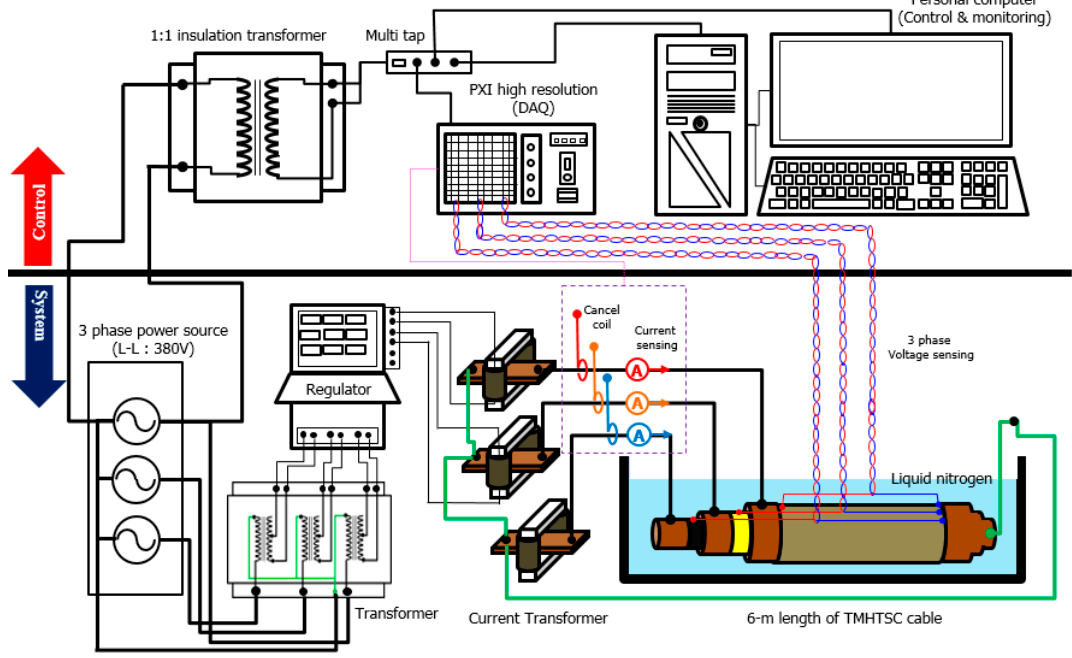
Figure 13. Configuration concept of AC loss measurement for the 6-m-long tri-axial HTS power cable.